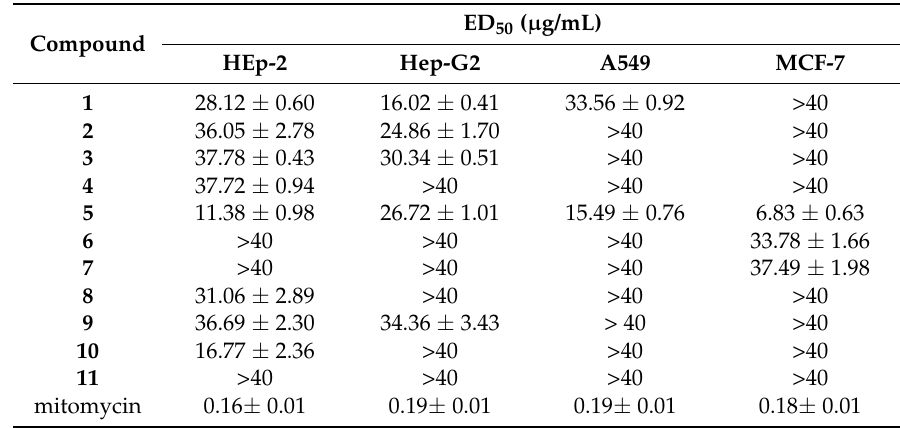
Table 3. Cytotoxic activities of compounds 1 – 11 a .